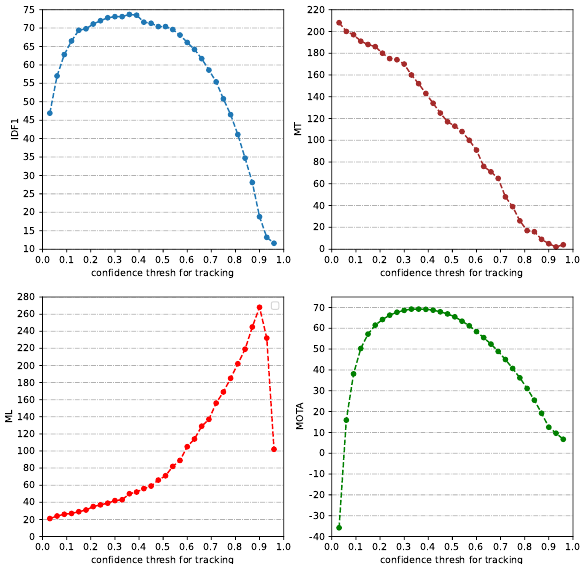
Figure 6. The change of IDF1, MT, ML, and MOTA indicators as the tracking confidence threshold